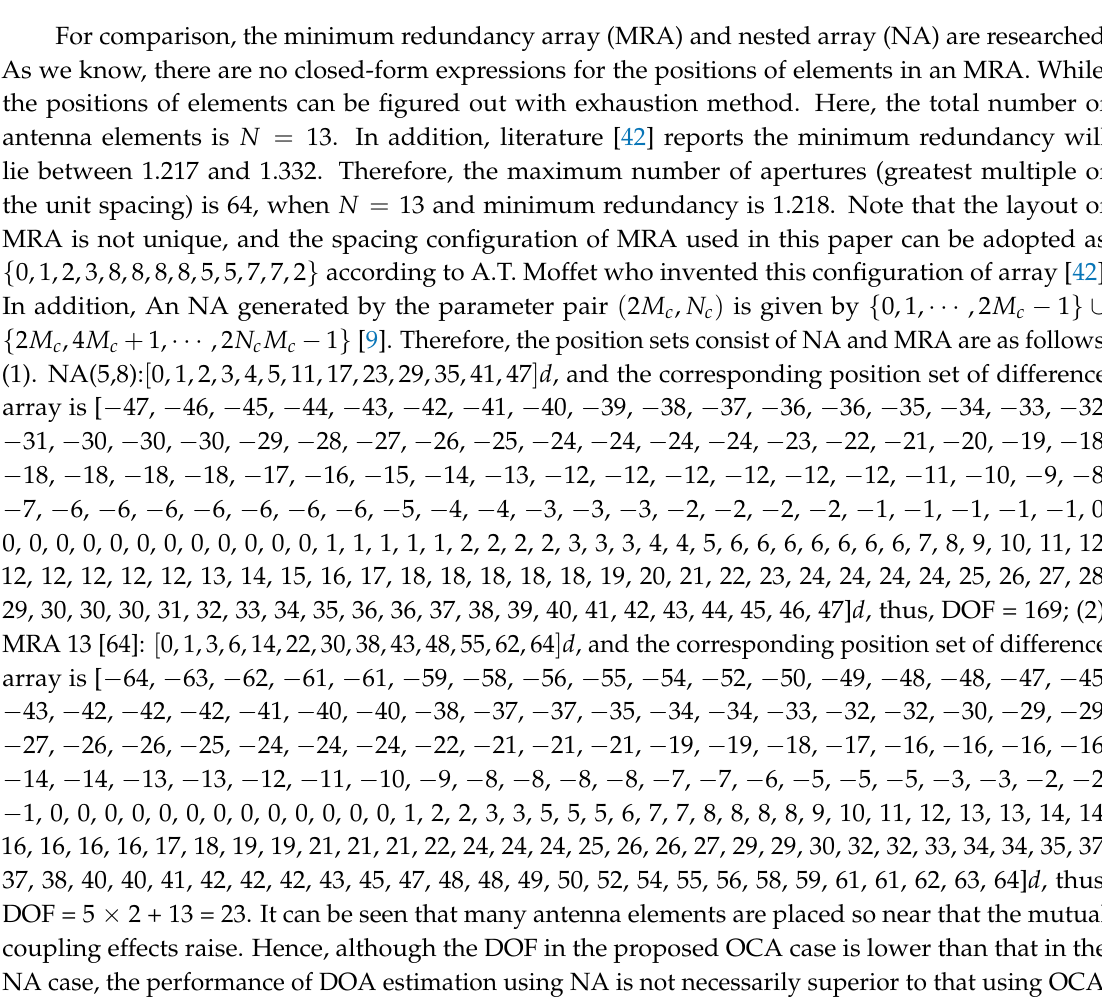
Figure 3. The distribution of the proposed DCA. Therein, the red circle represents the hole, and the white circle indicates the element of virtual ULA constructed by